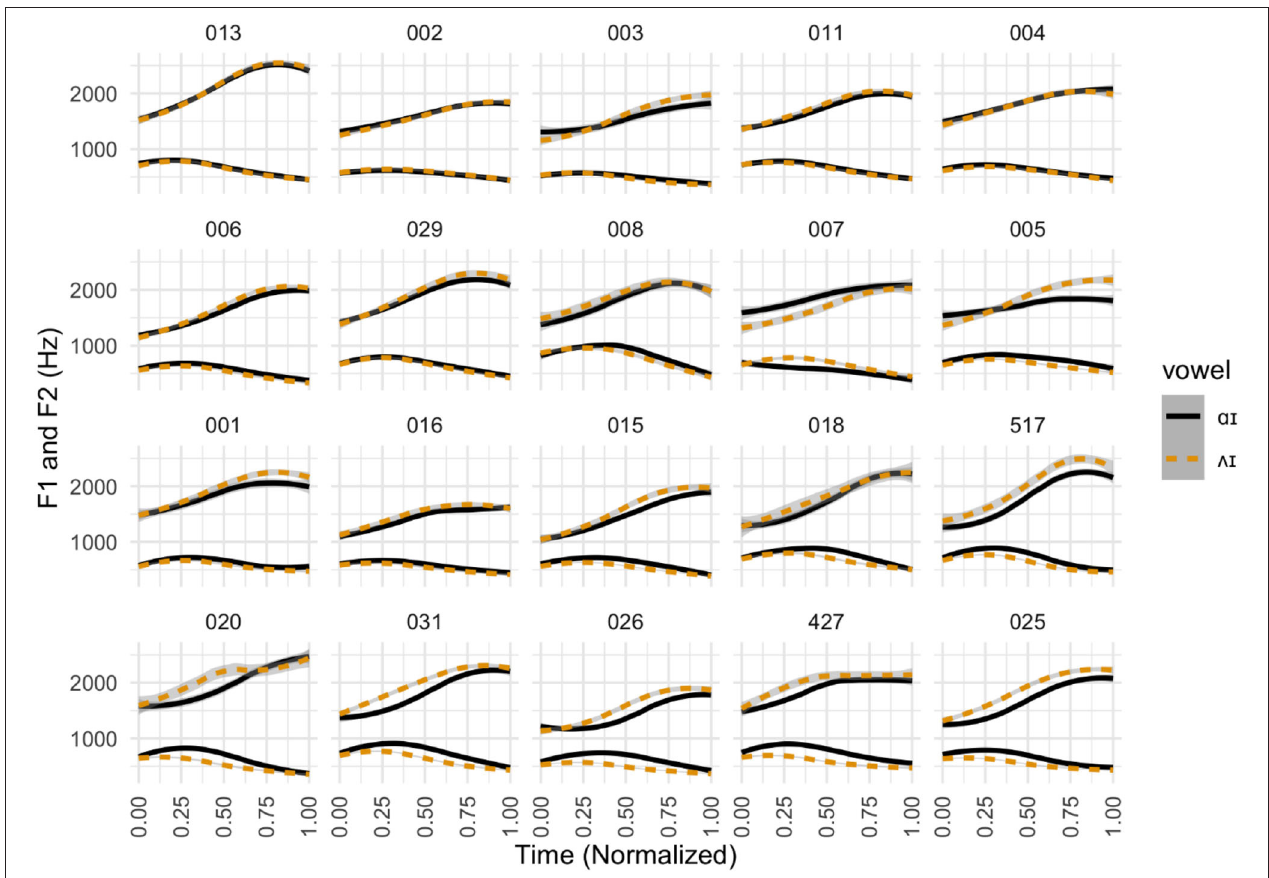
FIGURE 9 | Formant contours for writer-rider by participant. Individual time-normalized formant contours (F1 and F2) in Hz, separated by target phone. Speakers are organized from lowest to highest Pillai score at 30% duration of the